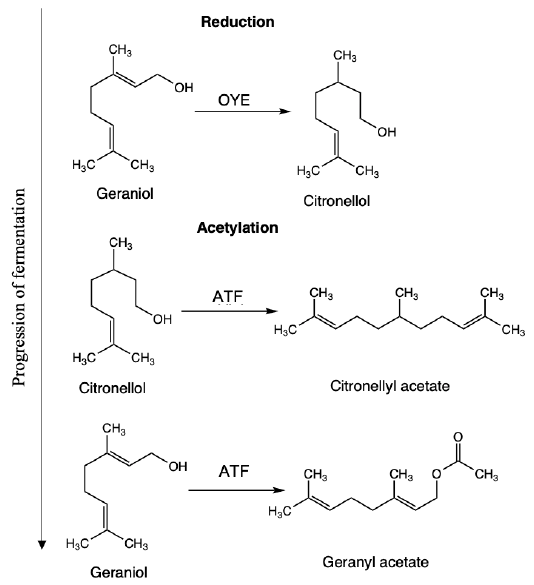
Figure 7. Proposed formation of citronellol, citronellyl acetate and geranyl acetate during fermentation. Enzymes (OYE and ATF) are based on literature [14,50,51].